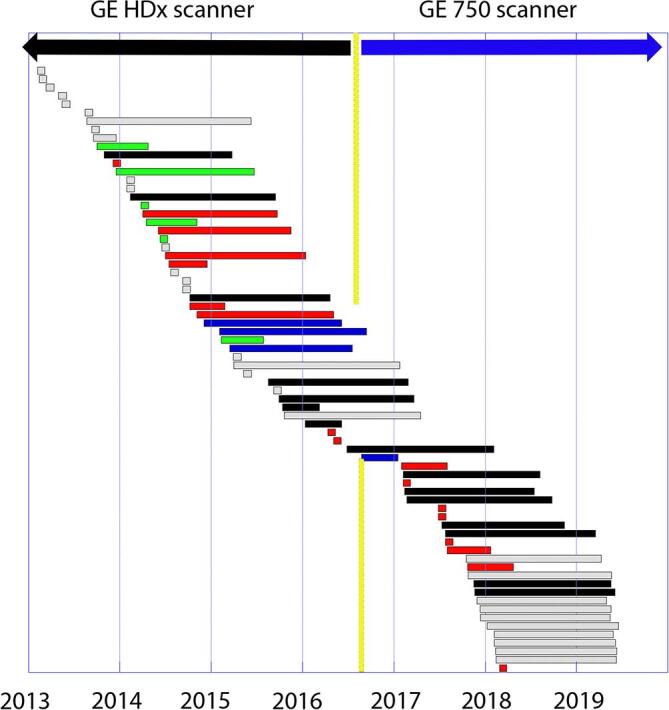
Timeline for acquisition of MRI scans for all subjects in this study. Grey=Healthy controls; Red = C9+ ALS; Green = C9+ ALS-FTD; Blue = Dementia; Black = C9+ presymptomatic carriers. The length of each bar represents the time from first to last scan acquired. Squares represent subjects with only a single scan. The yellow bar indicates the timing of the 3T scanner upgrade, from GE HDX to GE 750.